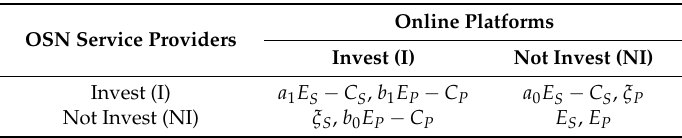
Table 1 delineate the payoff; the first entry shows the payoff for the OSN service providers, and the second entry is the payoff for the online platforms. Table 1. Payoff matrix.